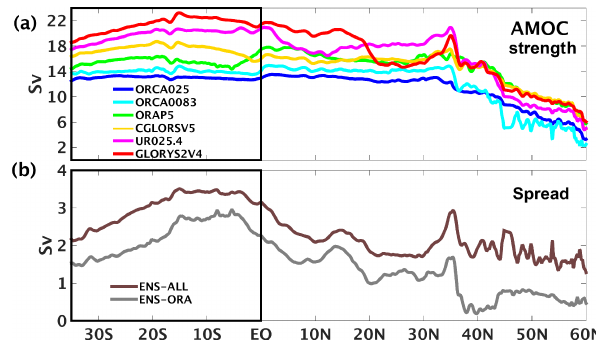
Figure 2. (a) The AMOC strength ψ max (Sv) averaged over 1997– 2010 as a function of latitude and (b) its spread (Sv) defined as the standard deviation of the ENS-ALL and ENS-ORA. The black box represents the study area between 35 ◦ S and the